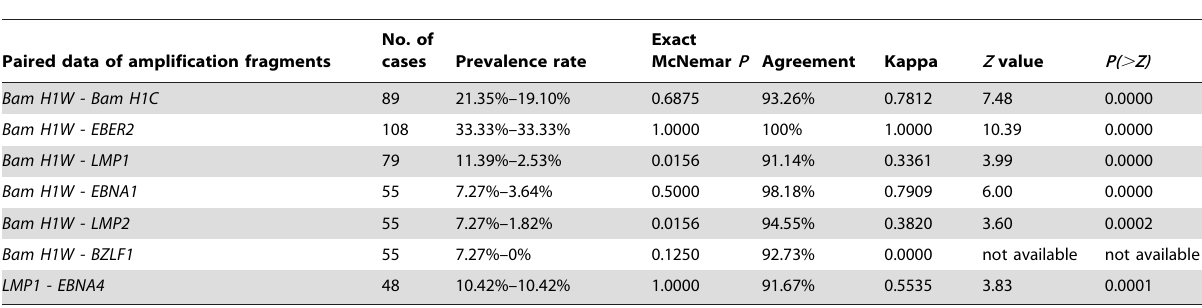
Table 3. Paired data of different detection fragments of EBV DNA.